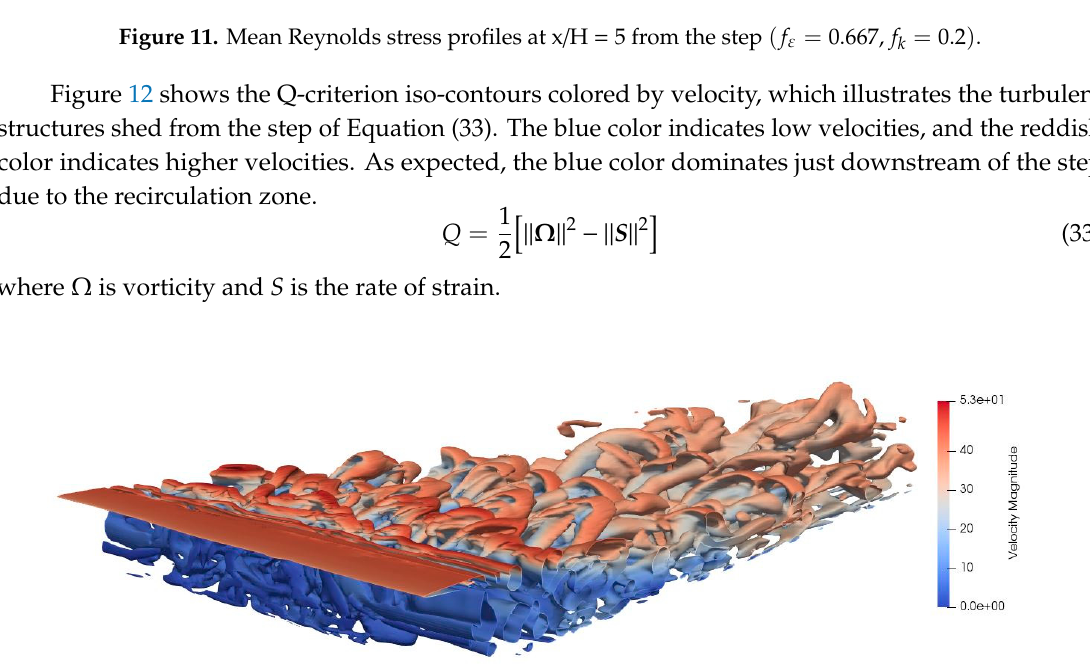
Figure 12. Q-criterion iso-contours colored by velocity for = 10 (cid:2873) (𝑓 (cid:3084) = 0.667, 𝑓 (cid:3038) = 0.2) .